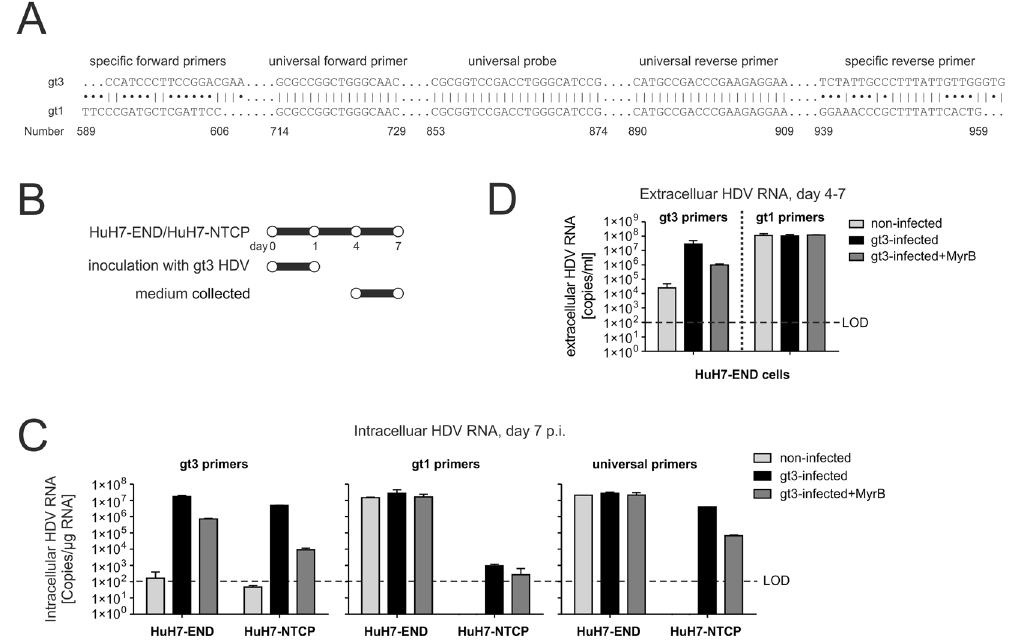
Figure 5. Infection of HuH7-END cells with genotype 3 HDV. ( A ) Alignment of genotype 1 and 3 HDV with respect to the primers used for quantification. The letter shown in the alignment is the binding site of three primer pairs (gt1, gt3 and universal) and the commonly used probe. ( B ) Scheme of HuH7-END cells infected with gt3 HDV (MOI of 300 genome equivalents/cell). HuH7-END cell or HuH7-NTCP cell were inoculated with gt3 HDV overnight. The cell at d7 p.i. were analyzed for intracellular HDV RNA using three primers pairs ( C ) and the culture supernatant between d4-7 post infection were quantified for gt1 or gt3 HDV ( D